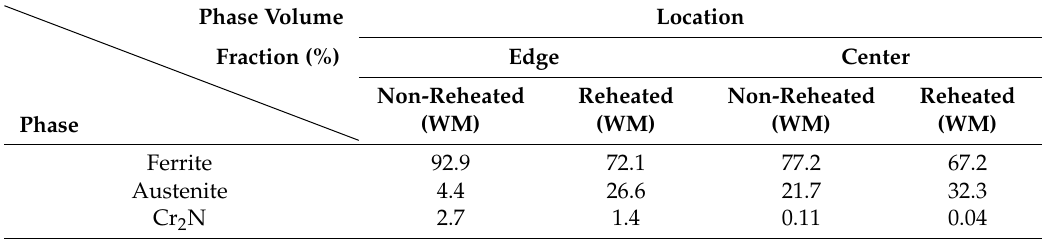
Table 5. Summary of phase fractions at the center and the edge of the weld of the medium heat input from the EBSD result.